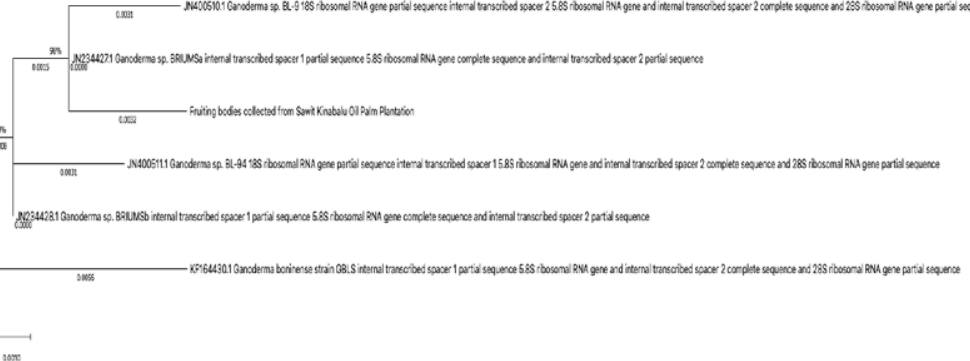
Fig. 2. Relatedness relationship of the collected fruiting bodies from the Sawit Kinabalu oil palm plantation with the five closest sequence retrieved from NCBI database. The topology was inferred by maximum likelihood. The bootstrap value is expressed in percentage and displayed next to each node. The branch length is drawn in scale with nucleotide change in unit of number of base substitutions per